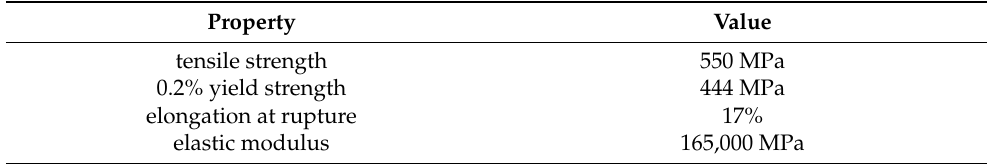
Table 2. Monotonic properties of